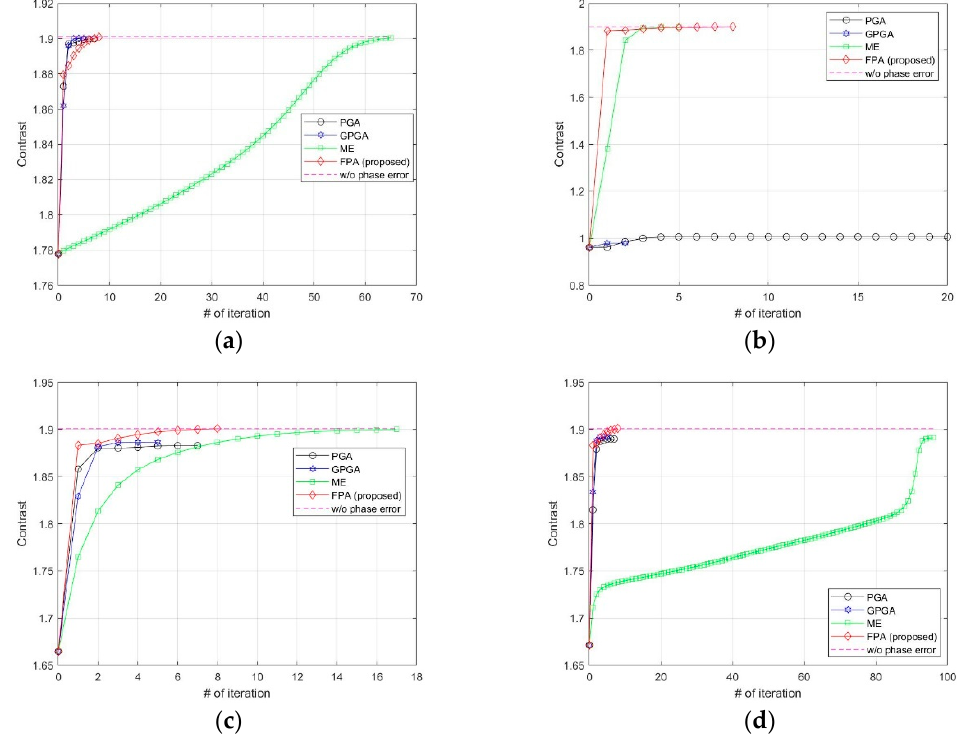
Figure 8. Contrast variations at each iteration for ( a ) quadratic error, ( b ) uniformly distributed random error, ( c ) Wiener process error, ( d ) sinusoidal error with discontinuity.